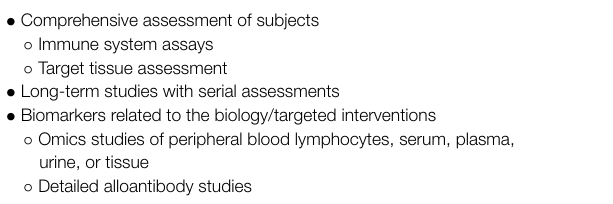
What happens between 5 and 10 years? We need to model these later time points and this will require data that are rarely